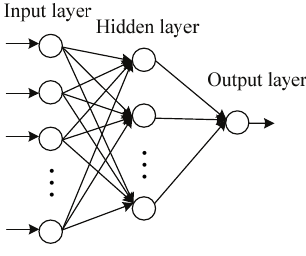
Fig.2. Given the